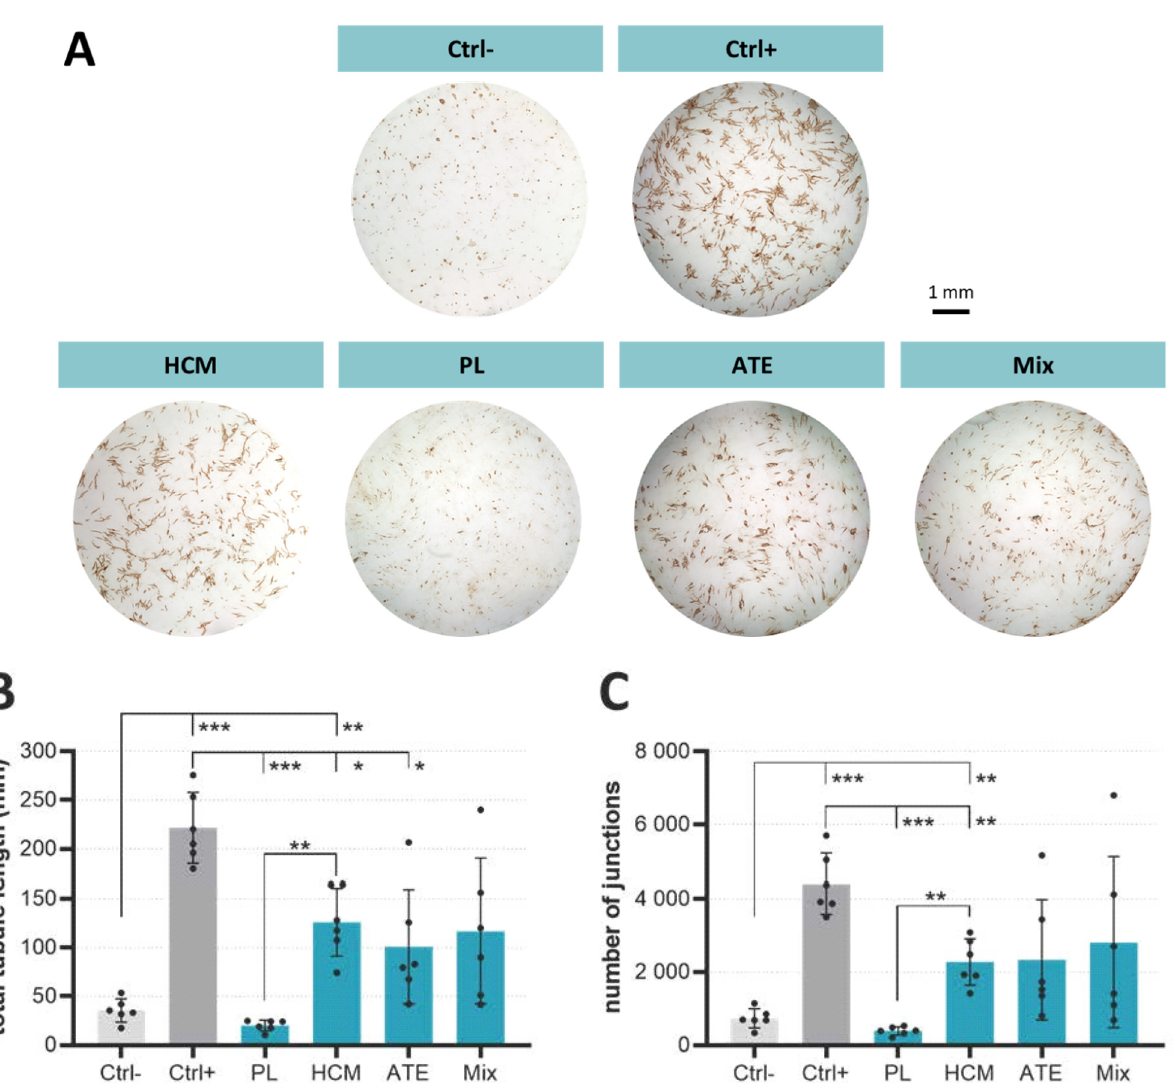
Figure 4. Angiogenic potential of supernatants containing released factors from the functionalized scaffolds as analyzed by a co-culture of hBM-MSC and HUVEC. ( A ) Light microscopic images of prevascular structures visualized by CD31 immunostaining after 7 days of cultivation, ( B ) total tubule length and ( C ) number of junctions (mean ± SD, n = 6 as represented by black dots within bars, Welch´s ANOVA following Dunnett´s T3 post hoc tests: * p < 0.05, ** p < 0.01, *** p < 0.001; Ctrl-: co-culture medium without bioactive factor mixtures/VEGF, Ctrl+: co-culture medium with 20 ng/mL VEGF).